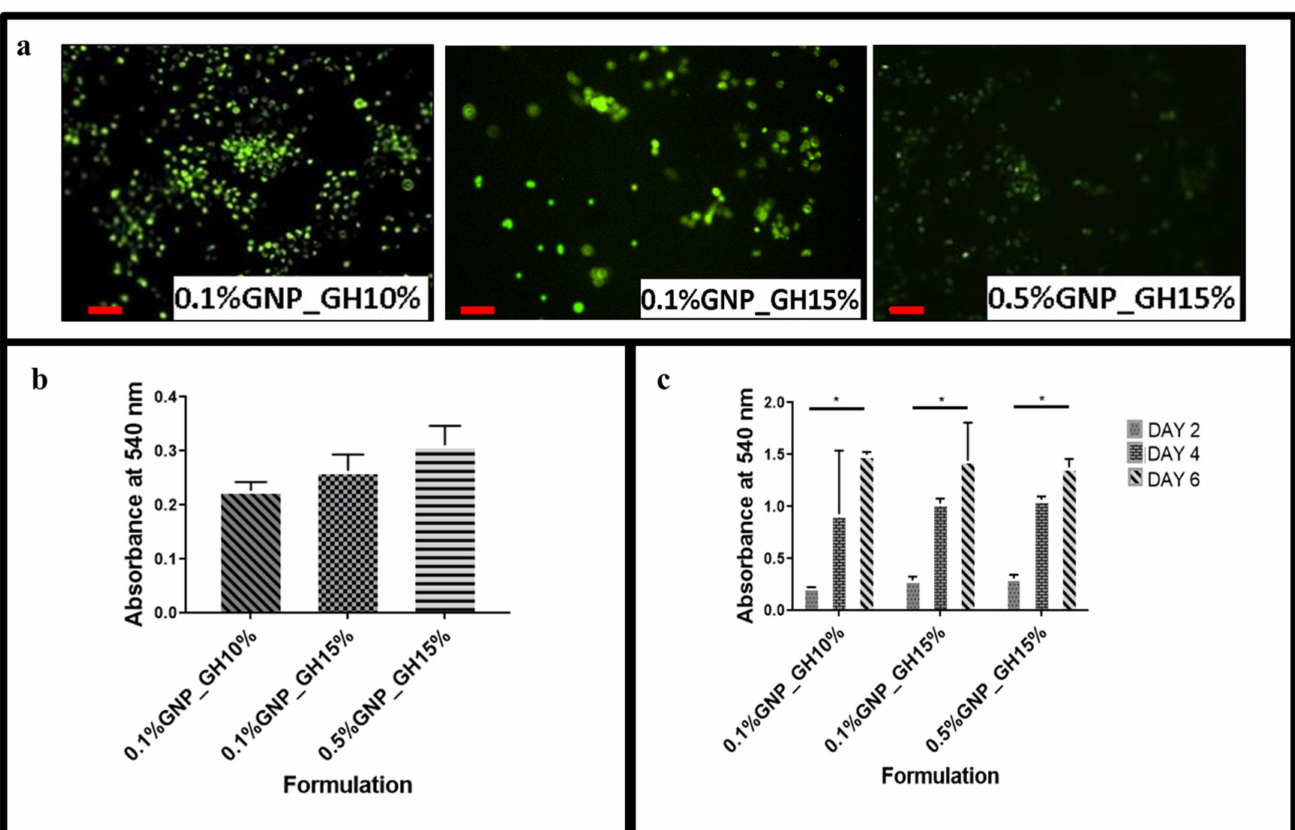
Figure 6. Cellular-hydrogel interaction. ( a ) Live/Dead assay revealed non-cytotoxic effect of GNP_GH. The green color demonstrated live human dermal fibroblasts. ( b , c ) MTT assay confirmed that human dermal fibroblasts could proliferate at the top of GNP_GH. * represented significant difference ( p < 0.05, n = 3, N = 3). Scale bar = 100 µ